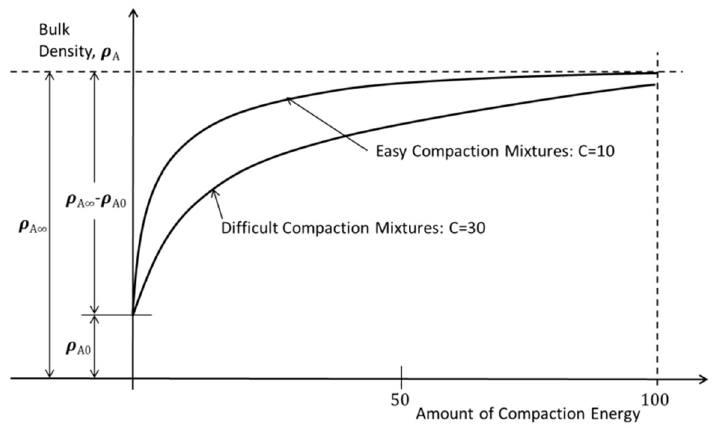
Figure 1. Compaction process as a function of compaction work [46].